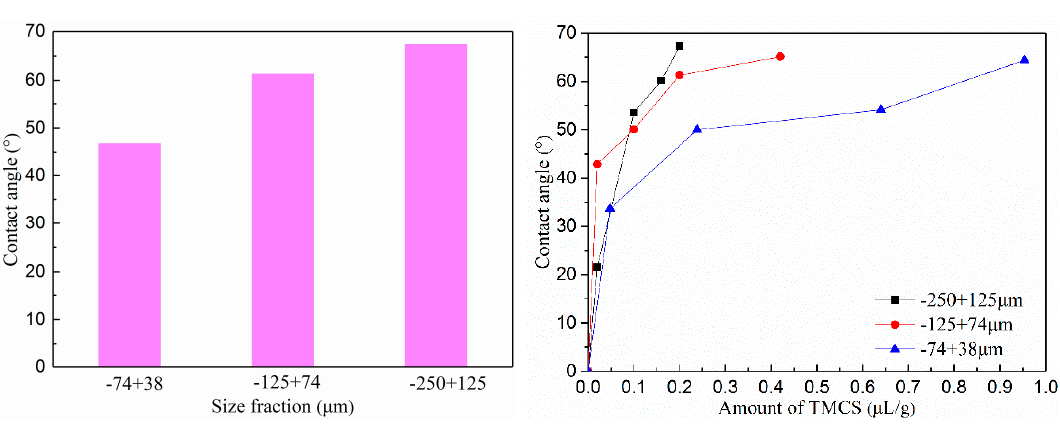
Figure 8. The contact angles of glass microspheres after modification (left: 0.2 μ L/g TMCS; right: different amounts of TMCS for different size fractions) .